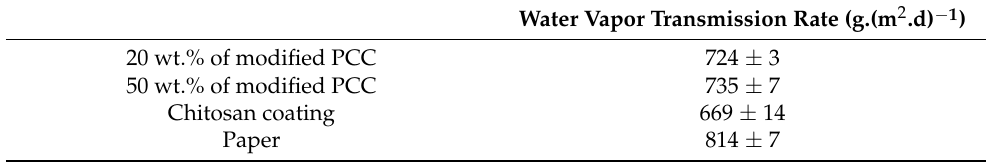
Table 4. Water vapor transmission rate of paper substrate and coated papers (23 °C, 50% RH).